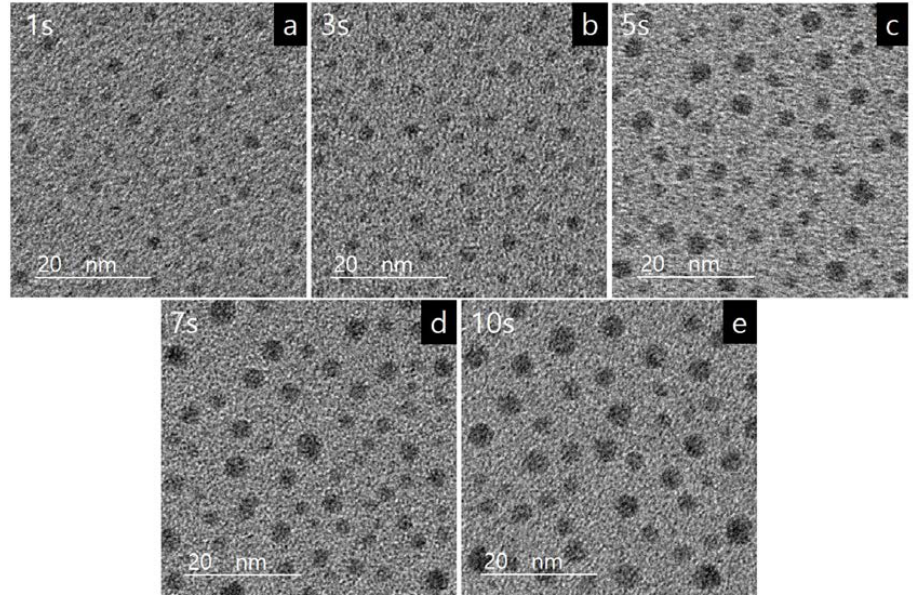
Figure 5. TEM images of Ag particles captured on an amorphous carbon membrane at the substrate bias of − 300 V for ( a ) 1 s; ( b ) 3 s; ( c ) 5 s; ( d ) 7 s; and ( e ) 10 s.